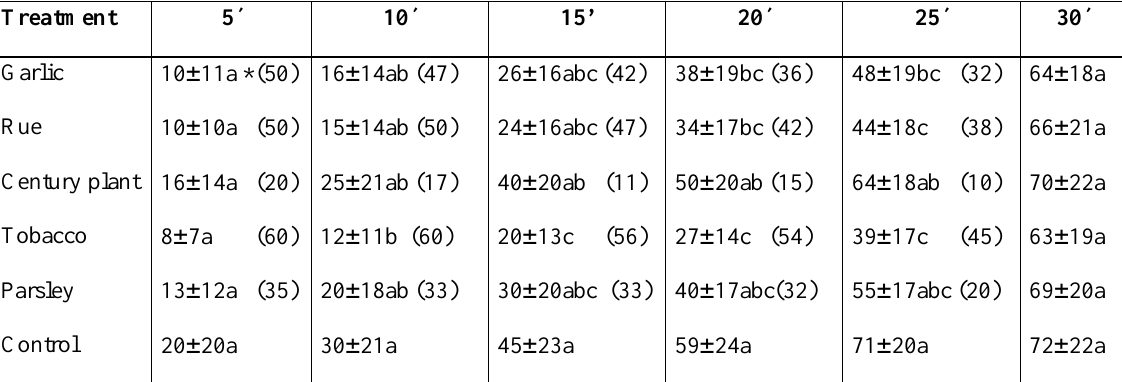
Table 1. Average number of Apis mellifera foragers and repellent action percentage against the control (in parentheses) for the 6 treatments up to 30 minutes after application of the extracts in twenty